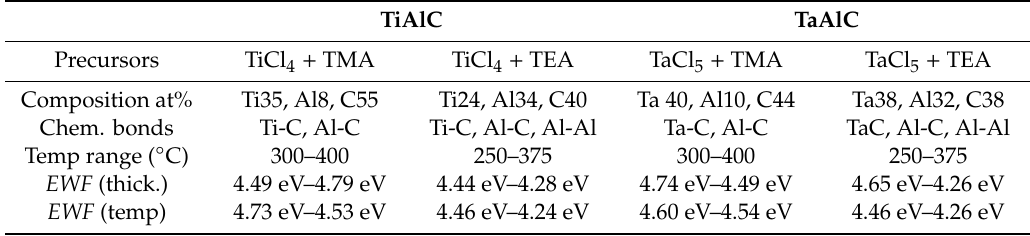
Table 2. Comparison of the properties of the TiAlC and TaAlC layers. TiAlC